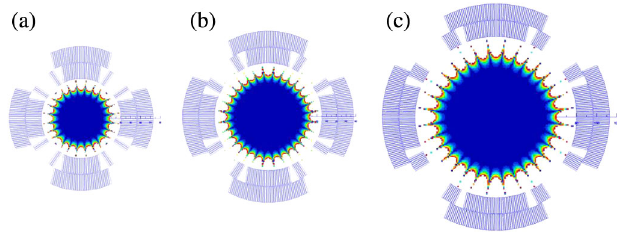
FIG. 4. Cross sections and a good-field region of Q1 (a), Q2 (b), and Q3–Q5 (c) quadrupoles. The dark blue color corre- sponds to the field error j (cid:2)B=B j < 10 (cid:2) 4